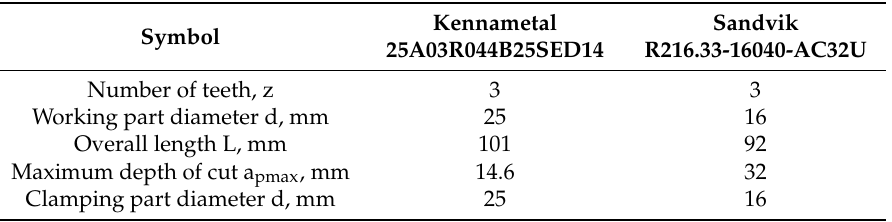
Figure 4. Tools used: ( a ) Kennametal indexable milling cutter, ( b ) Sandvik monolithic milling cutter. Technical parameters of the cutting tools used are summarised in Table 2. Table 2. Technical parameters of the cutters used [43,44].